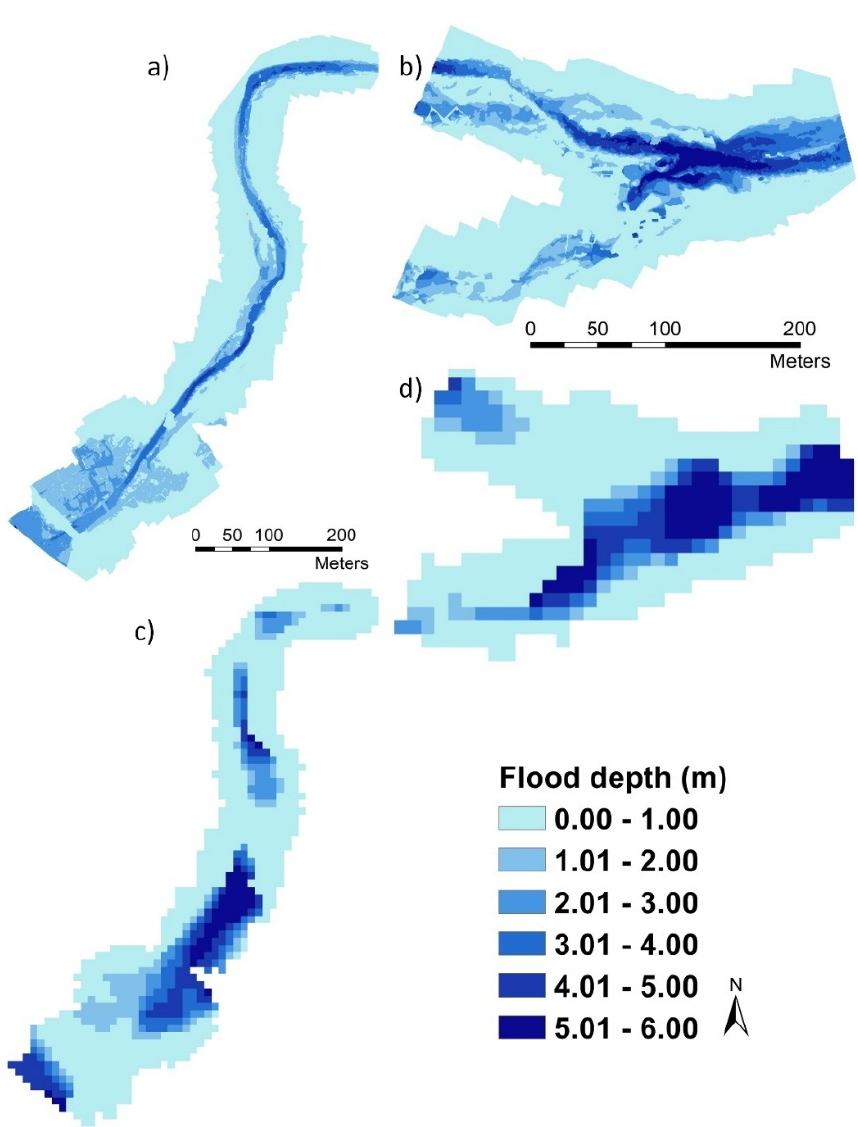
Figure 11. ( a ) Flood depth map for Coulibistrie: 3 rd order trend surface minus pre-event DTM filled with LiDAR DTM. ( b ) Flood depth map for Pichelin: 3 rd order trend surface minus pre-event DTM filled with LiDAR DTM. ( c ) Flood depth map for Coulibistrie: 3 rd order trend surface minus pre-event ALOS PALSAR DTM. ( d ) Flood depth map for Pichelin: 3 rd order trend surface minus pre-event ALOS PALSAR DTM. For brevity the maps generated with SRTM DTM are not presented here.